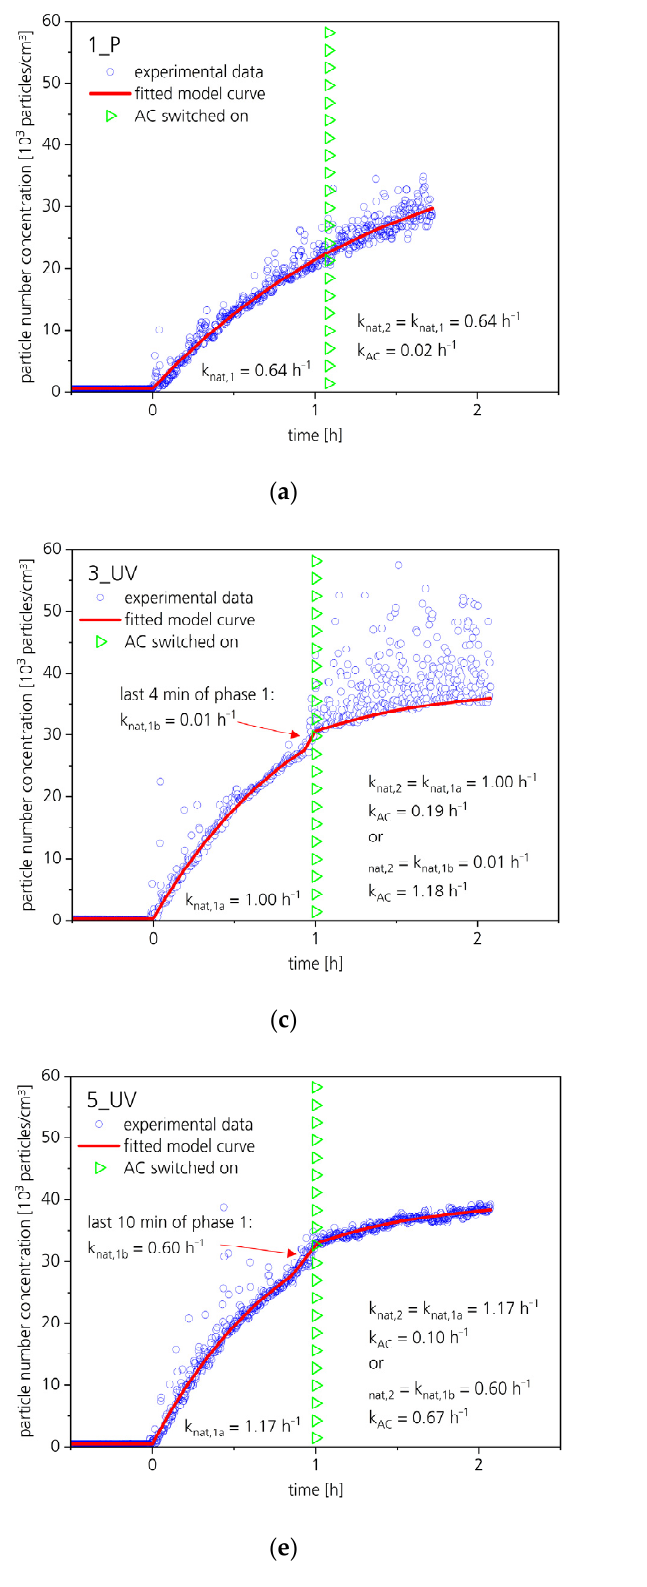
Figure 1. ( a – f ) Particle curves for all measured air cleaners and calculated loss coefficients k nat and k AC for particles (calculation see [54]).